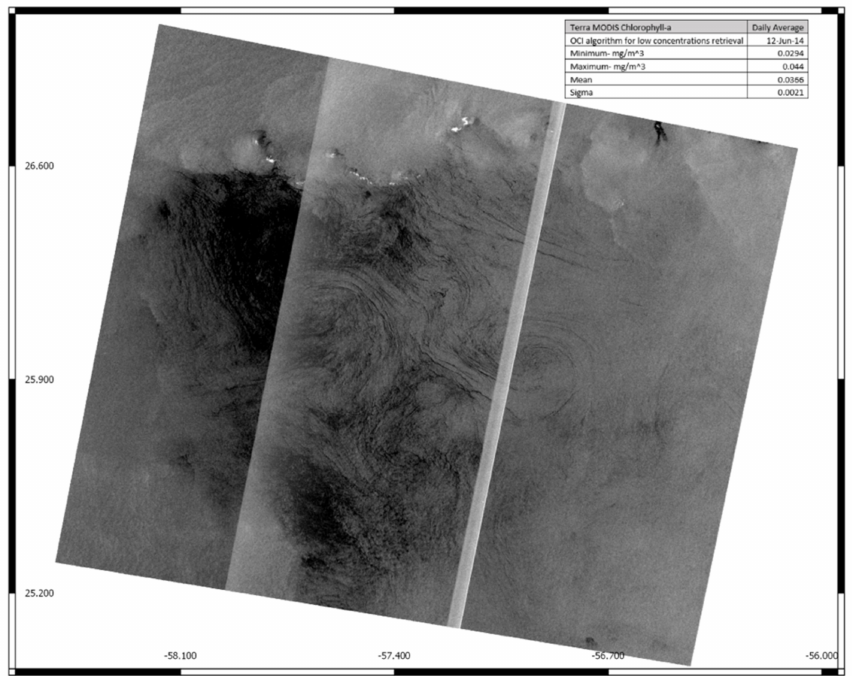
Figure 5. Sentinel-1A SAR image collected on 12 June 2014-09:43, with dark stripes attributed to surfactants.